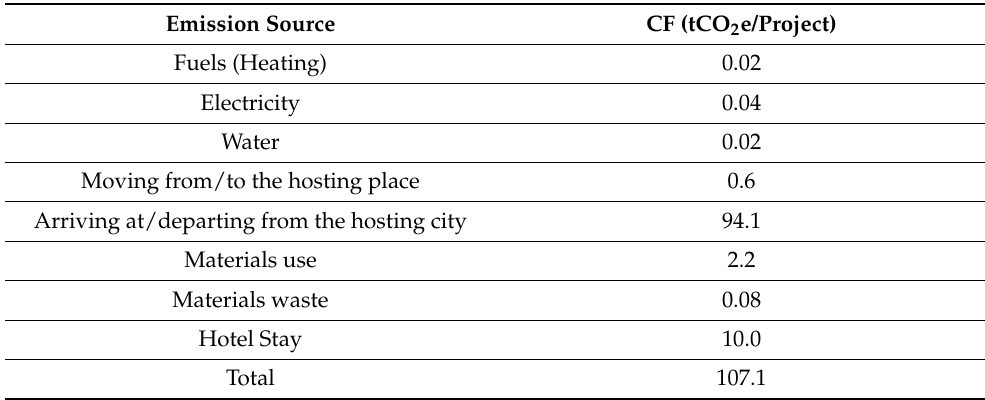
Table 4. Carbon Footprint (in tCO 2 e/project) of on-site events organized by the project for the base case scenario.